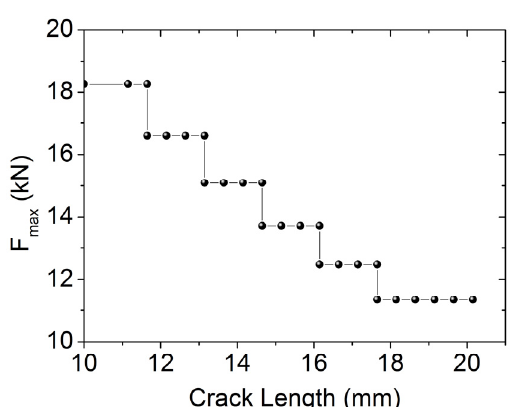
Figure 4: Load spectrum for the precracking phase.